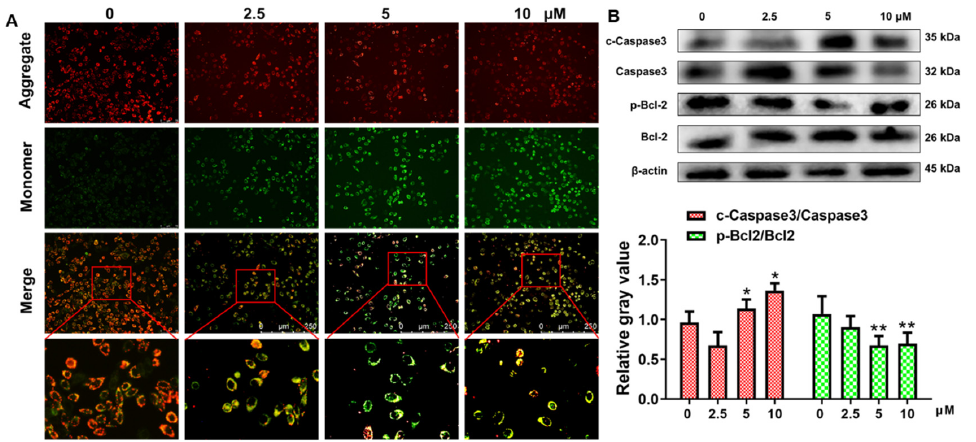
Figure 3. ( A ) The depolarization of mitochondrial transmembrane potential ( ∆Ψ m ) could be induced by compound B5 (0, 2.5, 5, 10 μ M) for 48 h, and then stained with JC-1 for 20 min at 37 °C. Both the loss of red fluorescence and the gain of green-emitting monomers indicated the disruption of the mitochondrial transmembrane potential ( ∆Ψ m ). The representative images are shown of the corresponding fluorescent channel (40× magnification). ( B ) HepG2 cells were treated with compound B5 (0, 2.5, 5, 10 μ M) for 48 h. Apoptosis-related proteins Bcl-2 and caspase 3 protein levels were determined by Western blotting. Image J software (version 1.8.0, National Institutes of Health, Bethesda, MD, USA) was used to analyze the levels of Bcl-2 and caspase 3 with β -actin as the reference. Data are represented by the mean ± SD of the three independent experiments. ** p < 0.01, * p < 0.05, compared with the 0 μ M group.